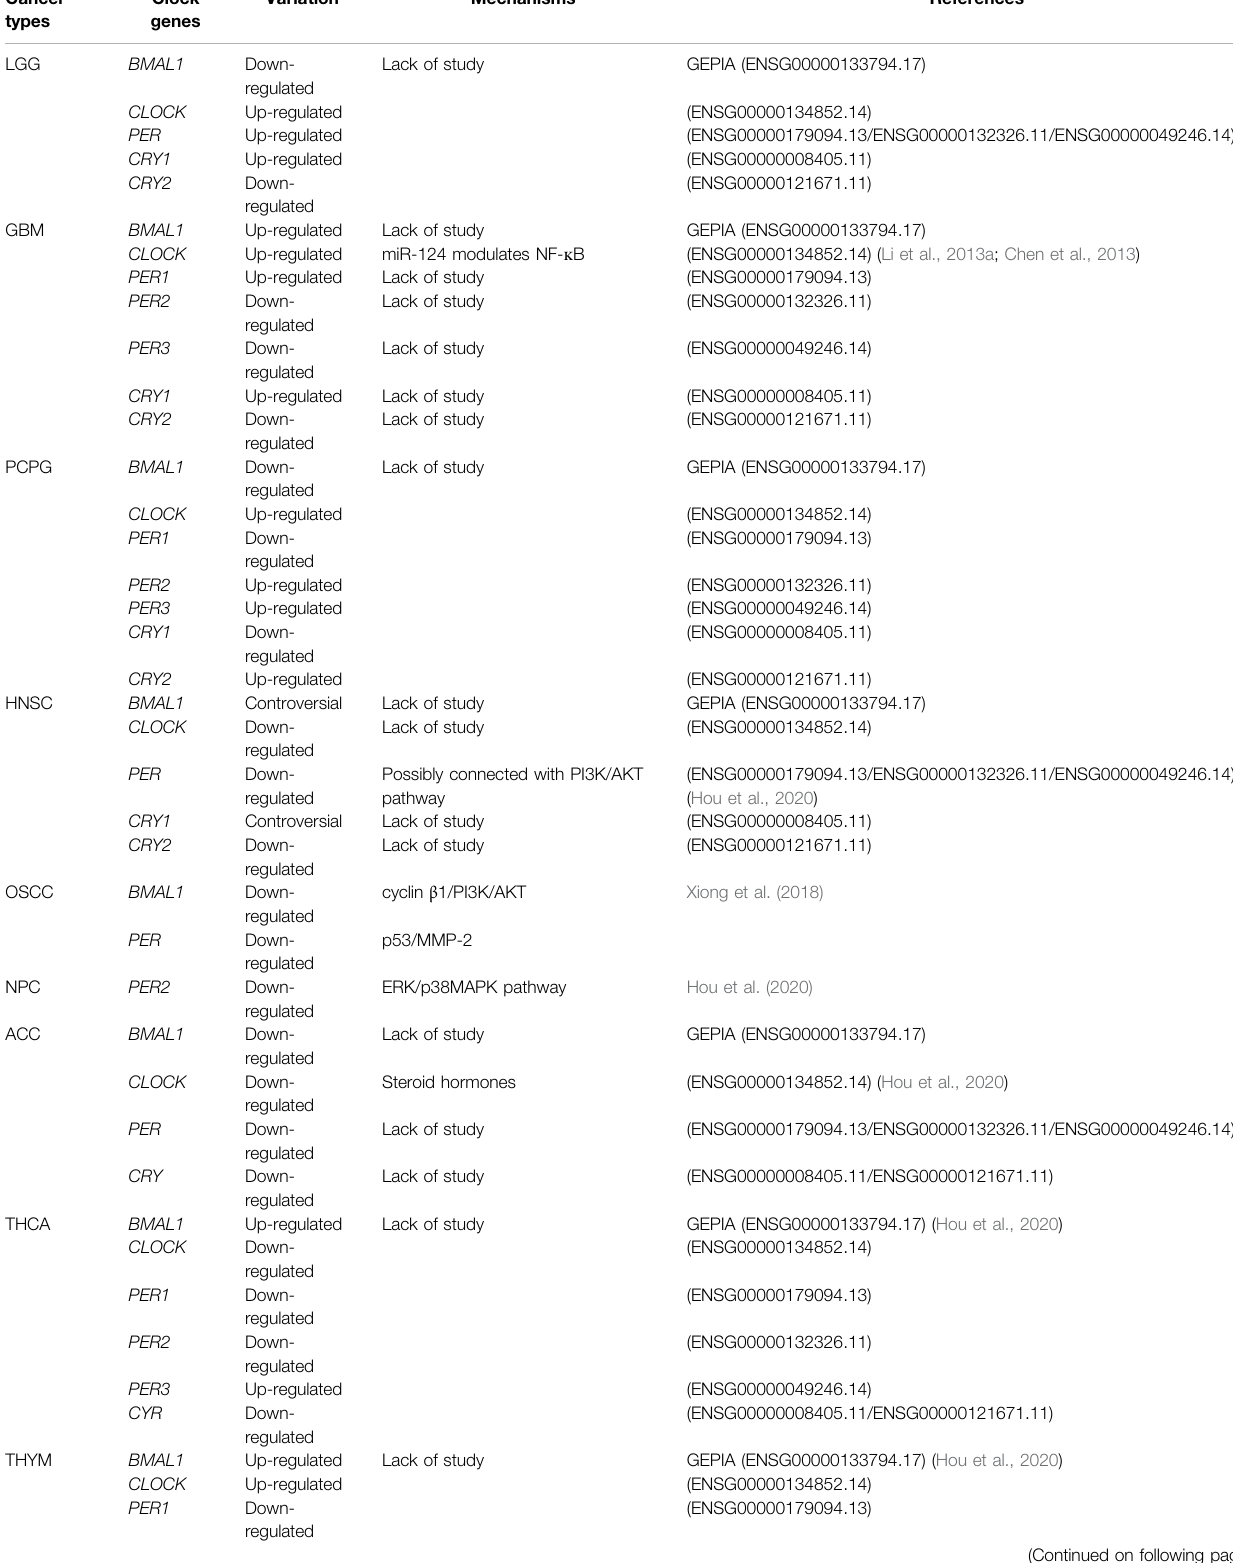
TABLE 1 | Variational expression of circadian clock genes in different types of